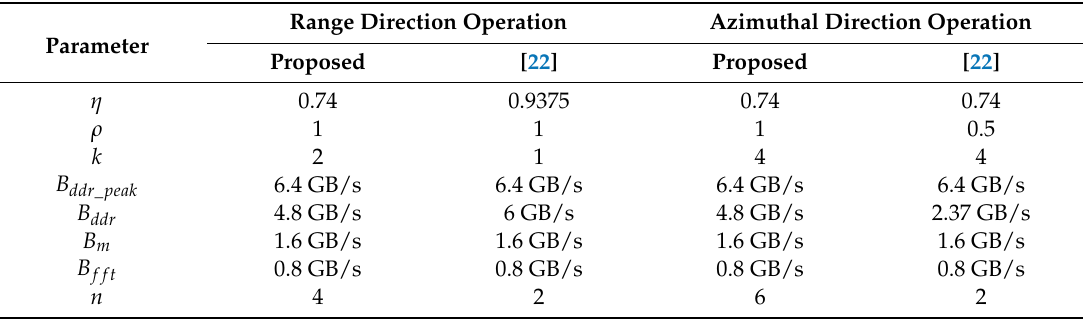
Table 4. Summary of the parameters related to parallel processing.